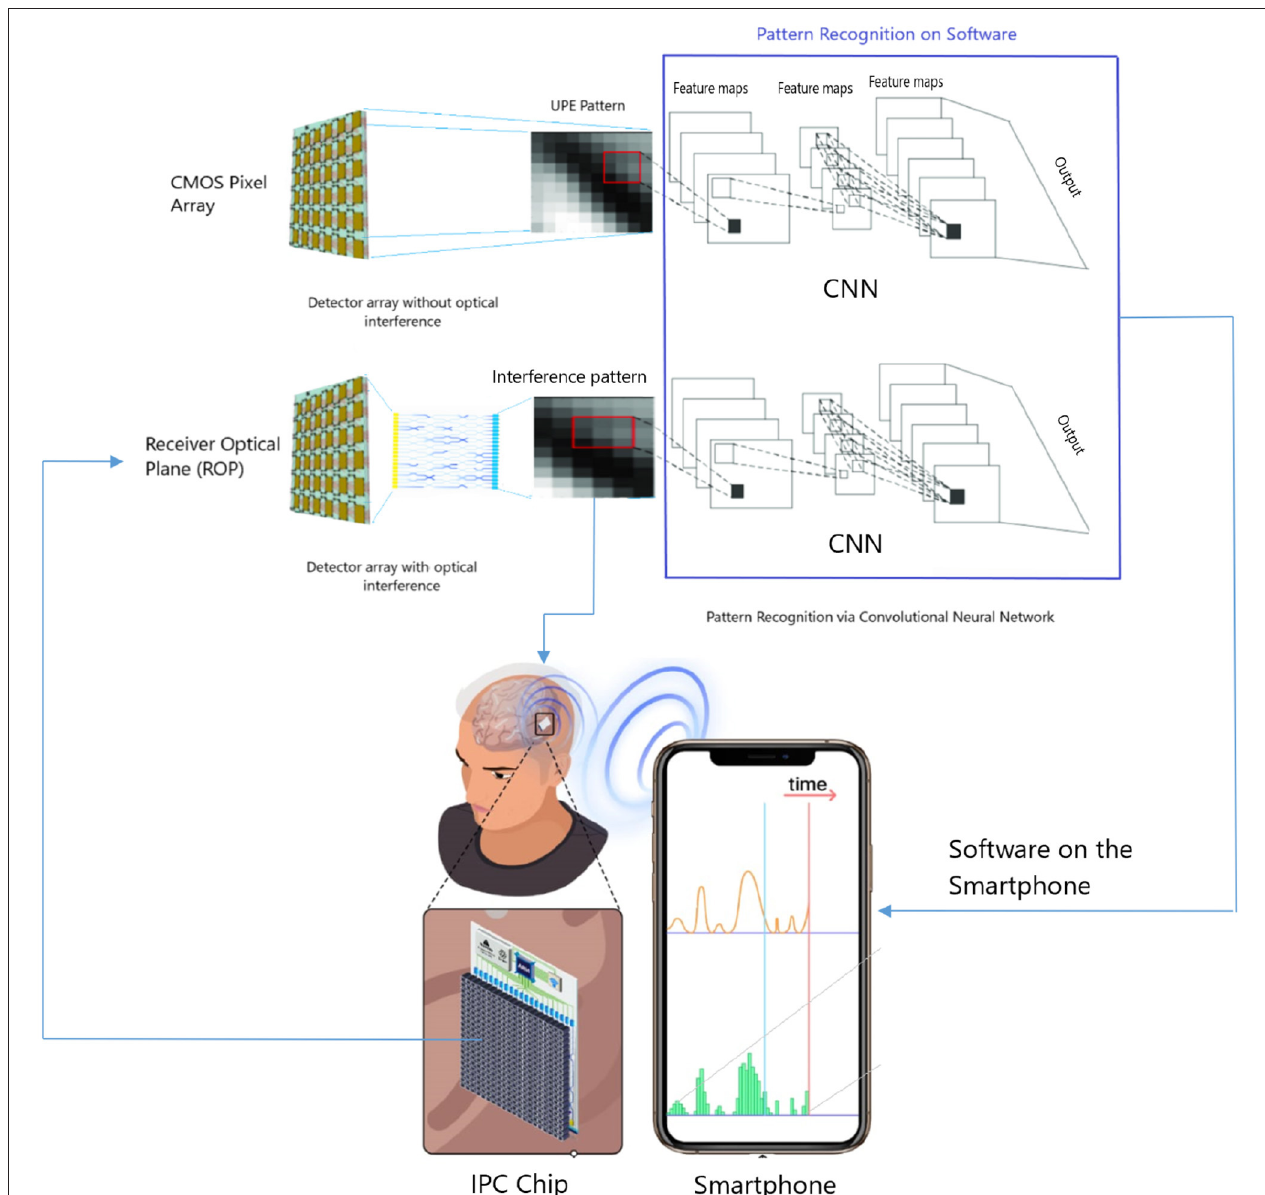
FIGURE 5 | Feature extraction and pattern recognition of detected ultraweak photon emission (UPE) by a chip composed of complementary metal-oxide-semiconductor (CMOS) array via convolutional neural network (CNN) on a software installed on a computer, machine, or smartphone; (top) direct UPE detection without optical interferometer, and (bottom) UPE detection after the interferometer. The existence of optical interferometer is to discriminate UPE wavelengths, since interference of similar photons (in wavelength) make a different pattern with non-similar photons. One of the advantages of such an interferometer is to have a simple “spectrometry” over similar wavelengths. However, an ensemble of wavelengths may make different patterns at the same time and obscure the interference patterns which may not make advantage over a direct detection, but one can classify those ensemble patterns with pattern recognition techniques such as PCA, which can find the differences between different patterns in the overlapped patterns, and classify each pattern for the relevant wavelength after many sets of training data. The direct detection of UPE by CMOS array and indirect detection after an optical interferometer both can be used for UPE data